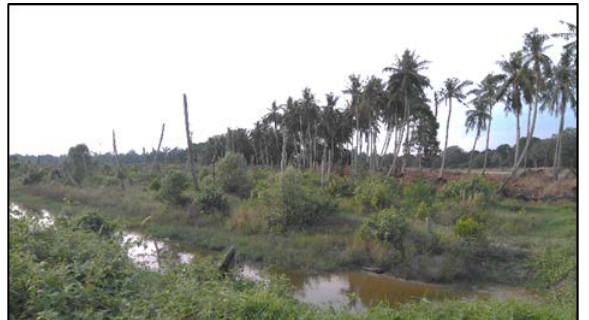
Figure 16. Coconut Tree That Destroyed the Effect of Changes in the Coastline